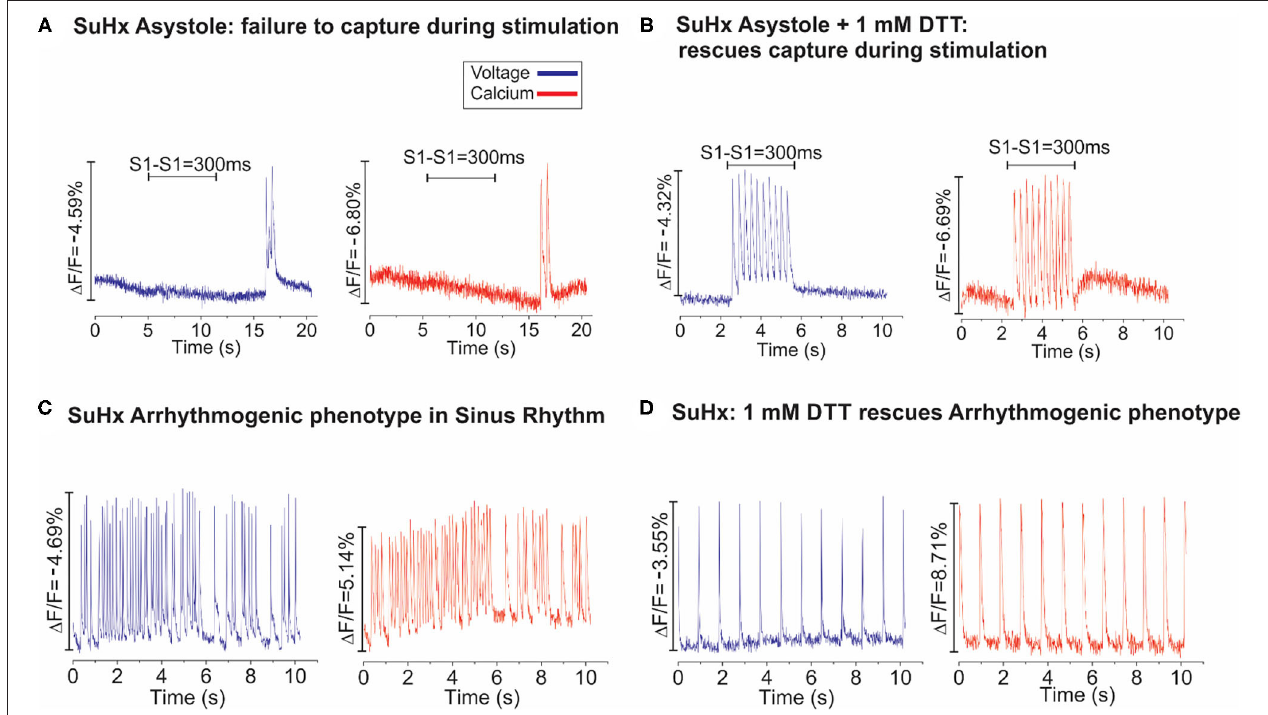
FIGURE 7 | Dithiothreitol (DTT) rescues PAH hearts. (A) : Dual optical mapping of voltage (blue) and Ca 2 + (red) illustrates an asystolic SuHx heart under sinus rhythm that fails to capture during pacing (S1–S1 = 300ms) with an occasional transient salvo of APs but is otherwise not excitable. (B) : The same heart was rescued by perfusing with 1mM DTT (2–3min), as electrical impulses now successfully capture at each stimulus ( n = 2/2 hearts). (C) : Voltage and Calcium mapping of a SuHx heart in sinus rhythm illustrates spontaneous bursts of tachycardia which typically progress to sustained VF. (D) : Perfusion of the same heart with DTT (1mM) stabilized the intrinsic sinus rhythm for the remainder of the experiment ( n = 2/2).